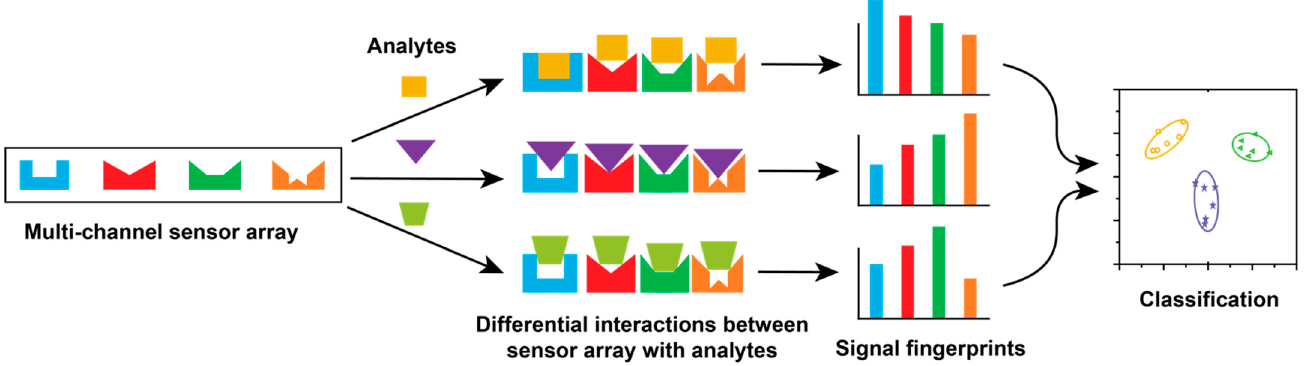
Figure 1. Schematic illustration of the array-based sensing platform. The multiple recognition elements in the sensor array interact with each analyte, generating distinguishable signal fingerprints, which can be classified using multivariate data analysis.